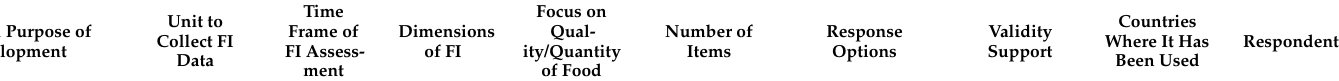
Table 4. Overview of measurement tools of food insecurity drawn upon in peer-reviewed articles and grey